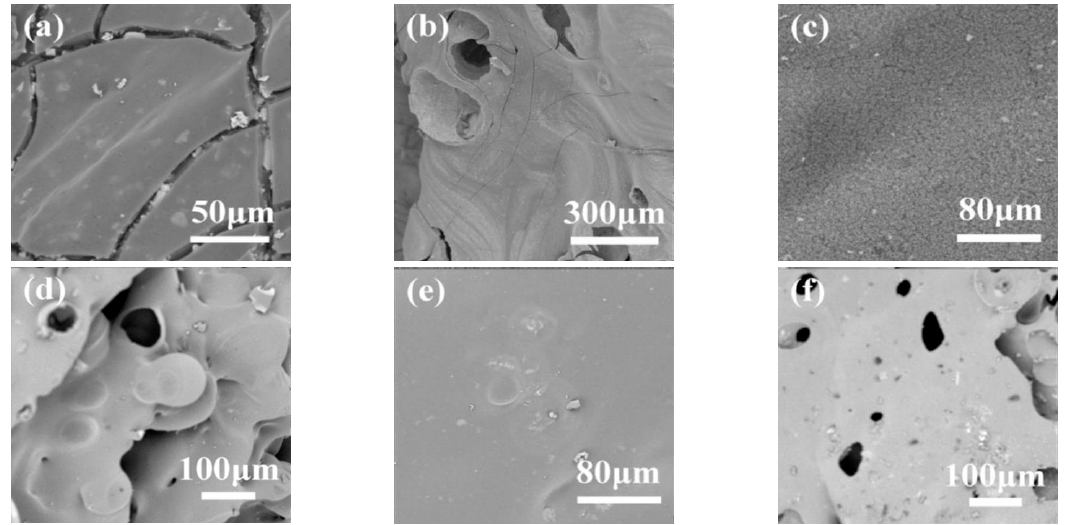
Figure 6. SEM images of char layer: ( a ) external and ( b ) internal char layer of pure EP; ( c ) external and ( d ) internal char layer of EP/2 wt% AVOPh composites; ( e ) external and ( f ) internal char layer of EP/6 wt% AVOPh composites.